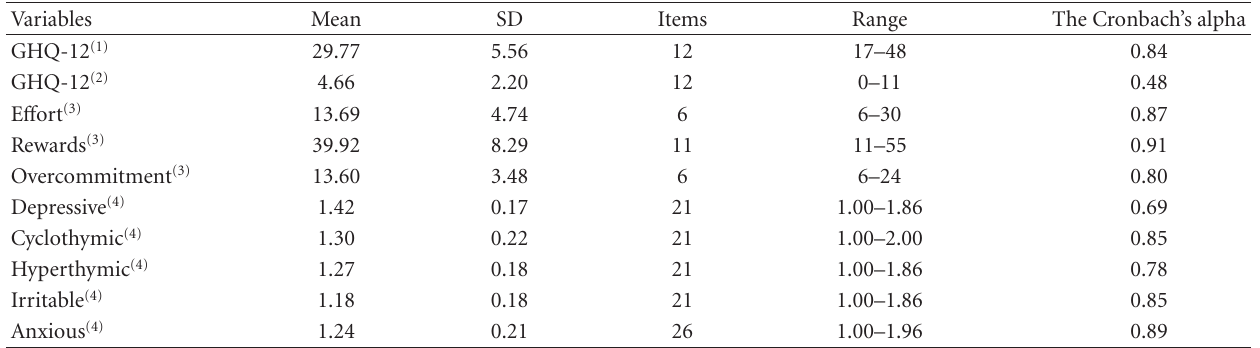
Table 2: Descriptive statistics and Cronbach’s alpha coe ffi cients of dependent and independen variables ( N = 728).